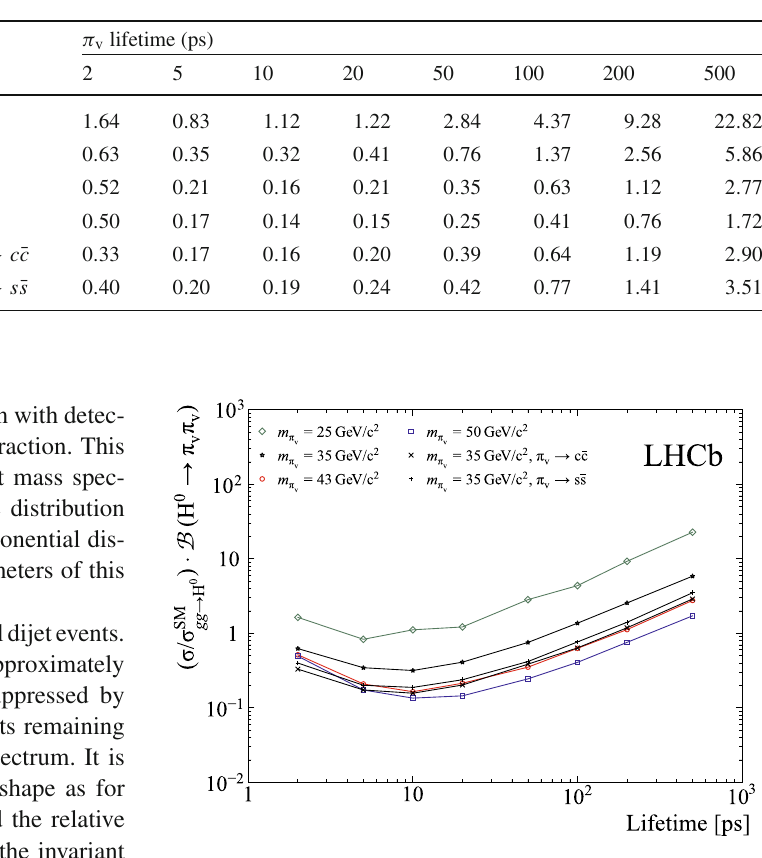
larger than with the nominal background model, leading to tighter limits on the signal. As the nominal model gives the most conservative limit, no additional systematic uncertainty is assigned for background modeling. There is no significant excess of signal in the data. Upper limits at 95% confidence level (CL) as a function of lifetime for hidden-valley models with different π v mass and decay mode are shown in Fig. 3 and summarized in Table 4 and Fig. 4. The best sensitivity is obtained for a mass of about 50 GeV / c 2 and a lifetime of about 10 ps. The main improve- ments with respect to the previous result [9] are due to the enlarged data sample, the improved trigger selections, and the addition of the R xy bin above 5 mm, which contributes to the increased sensitivity at larger